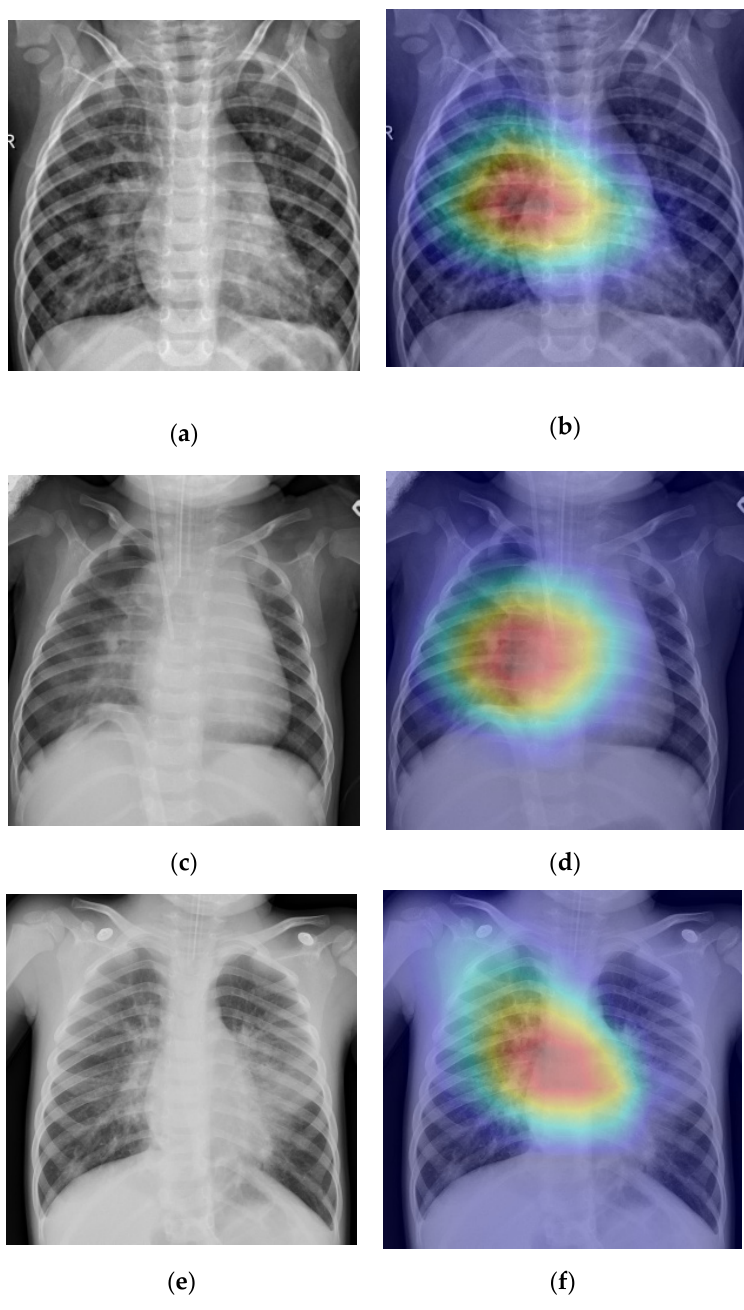
Figure 13. Grad-CAM of some pneumonia test images: ( a , c , e ) show the original and preprocessed images; ( b , d , f ) show their corresponding heatmaps.